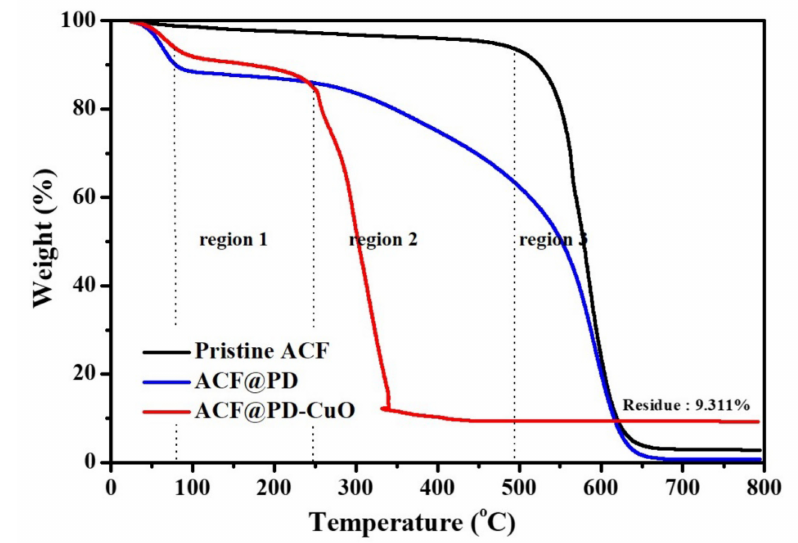
Figure 3. TGA curves of pristine ACF, ACF@PD, and